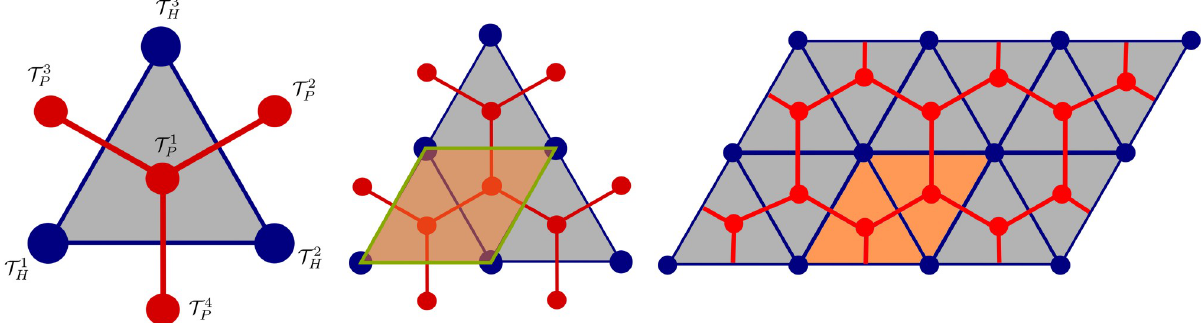
Fig 4. Construction of the LRPC. Left: Portal lobule unit associated with Y (5) and (6), and generate the periodic lattice.